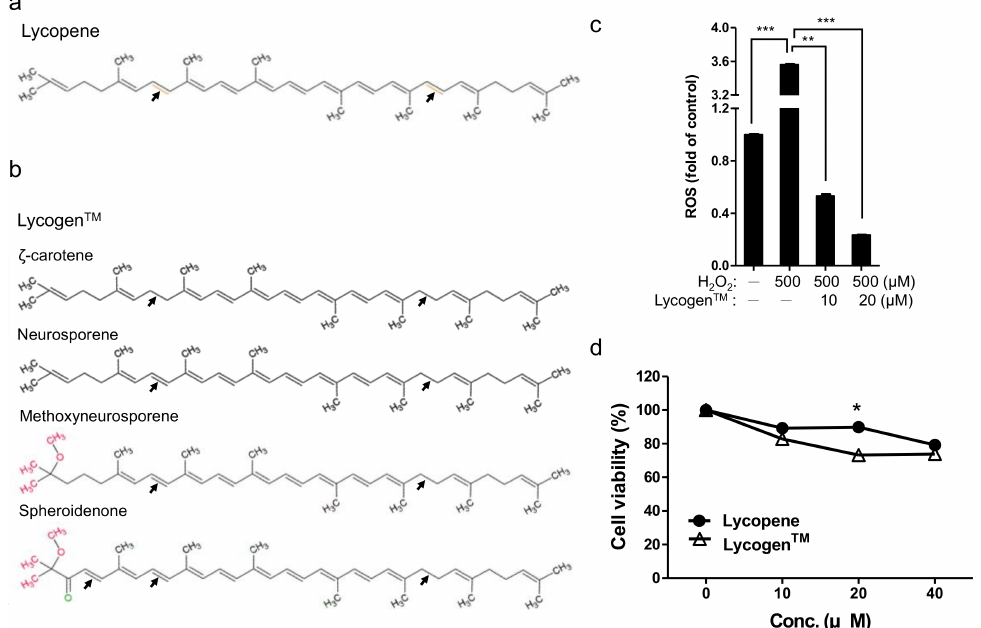
Figure 1. Anti-oxidative property of Lycogen™ and potency comparison of lycopene and lycogen™. The structure of lycopene ( a ) and Lycogen™ ( b ) were showed. Lycogen™ structures, including ζ -carotene, neurosporene, spheroidenone, and methoxyneurosporene were illustrated. ( c ) Detection of ROS in lycogen™-treated HK-2 cell. Histogram showing the relative fluorescence intensity of H 2 DCFDA labelling cells. Significant reduction of ROS level was observed in 10 and 20 µ M lycogen™-treated HK-2 cell. ( d ) Cell viability of DU145 cell with either lycopene or lycogen™ treatment were measured by MTT assay. Histogram showing the dose-dependent decrease of lycogen™ treated DU145 cell. Significant reduction of cell viability by 20 µ M lycogen™ treatment was marked. Error bars represent ± SD. * p <0.05, ** p <0.01 and *** p <0.001, Student’s t